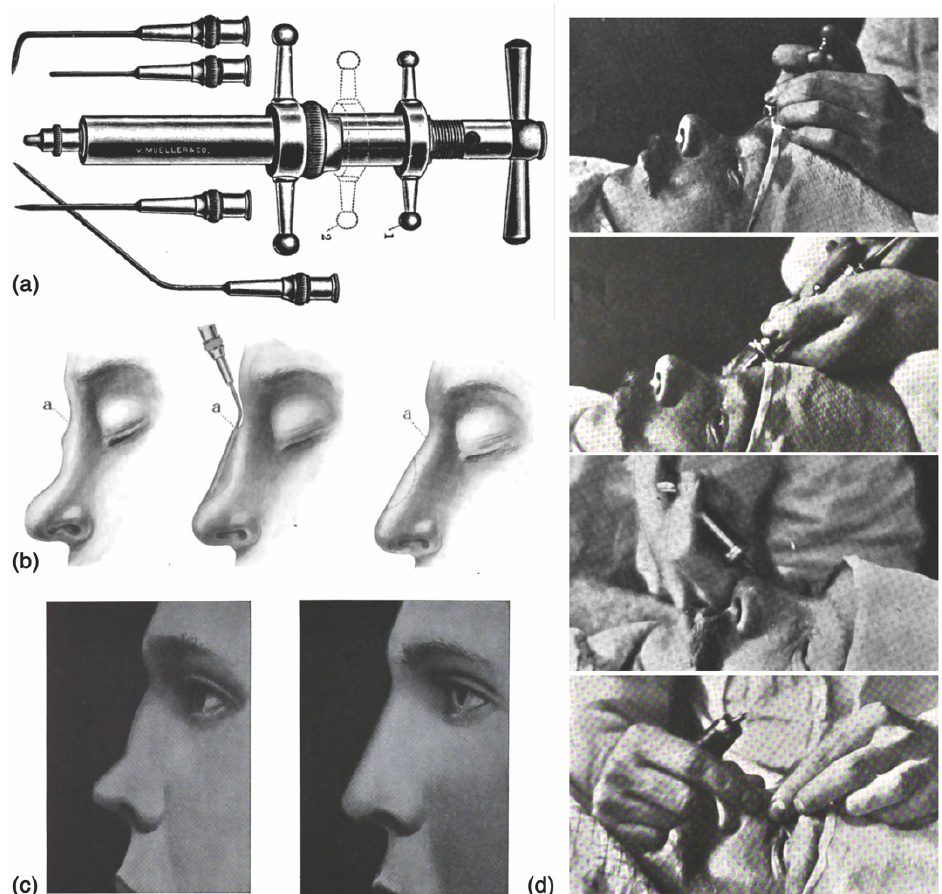
Figure 1. The history of cosmetic injectable fillers, early 1900s: ( a ) Paraffin syringe employed in paraffin facial injections, from Ballenger [6]. ( b ) Diagrammatic description of nasal dorsal augmentation with paraffin, ca. 1911, from Ballenger [6]. ( c ) Illustration of cosmetic patient before and following paraffin augmentation of the nasal dorsum, early ca. 1911, from Kolle [7]. ( d ) Procedural technique of paraffin injection in the correction of a dorsal nasal deformity, ca. 1908, from Miller [8].